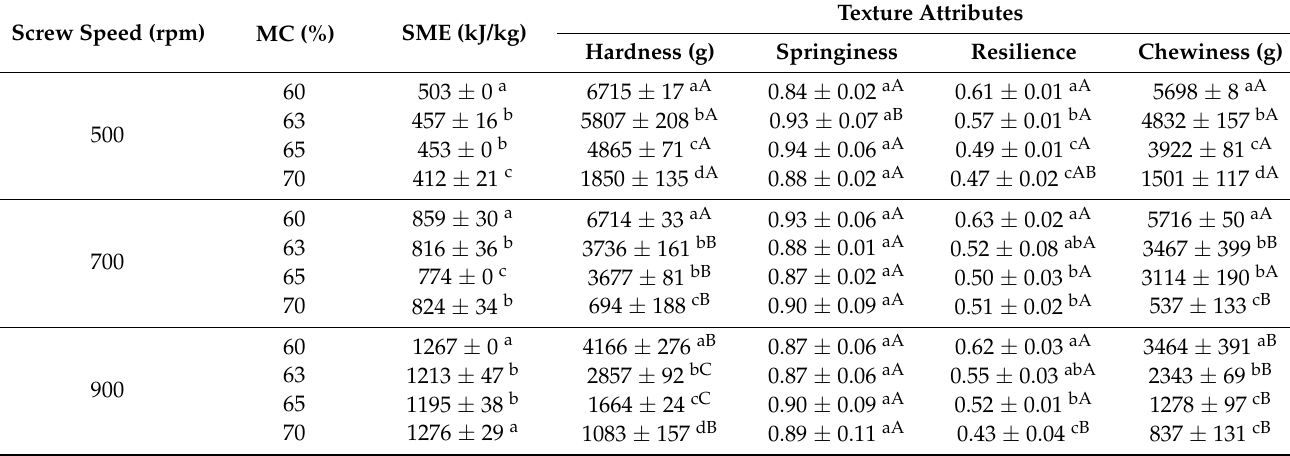
Figure 4. Fibre structure of extrudates from RPC:YPI mixture at 900 rpm and different target moisture content: ( a ) 60% MC; ( b ) 63% MC; ( c ) 65% MC. Table 7. Texture profile analysis result of extrudates from mixed protein (RPC:YPI) at different screw speeds and target moisture